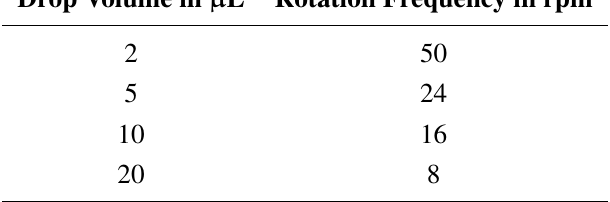
Table 1. Rotation frequencies of the bulb as varying with the volume of the suspended